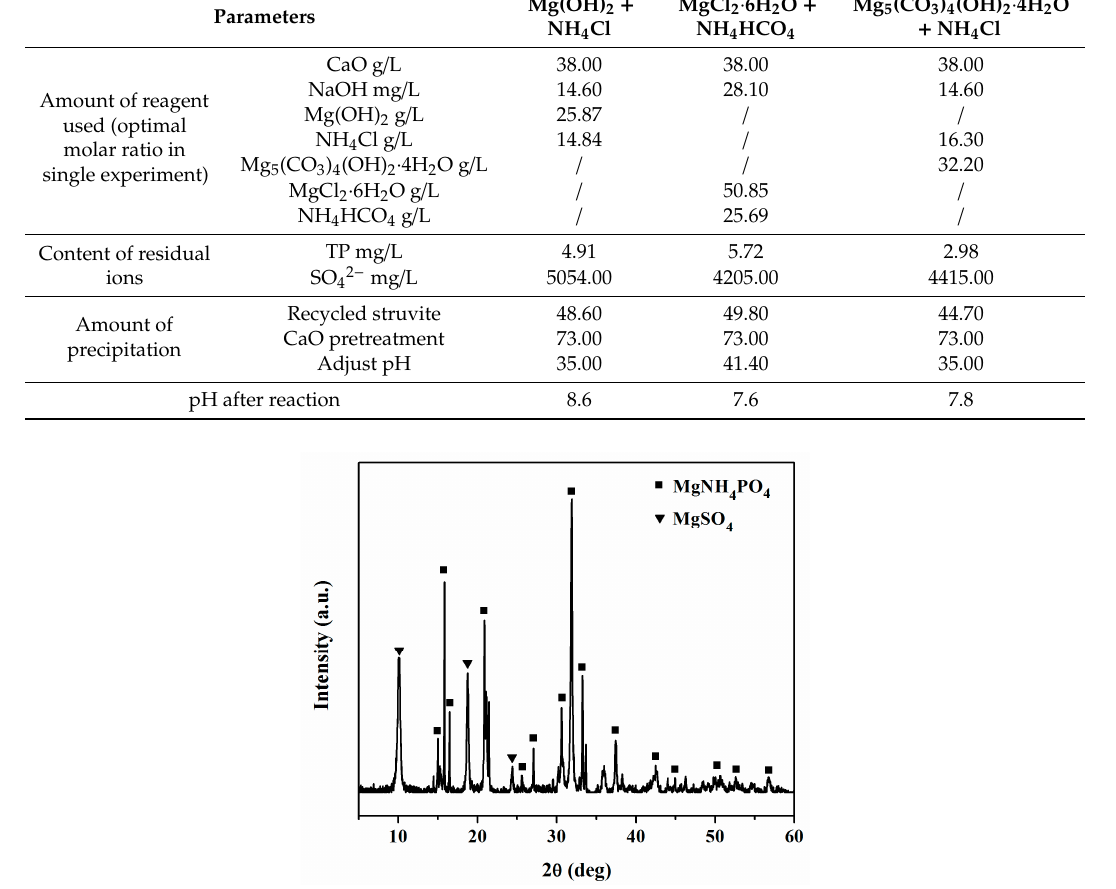
Figure 3. XRD patterns of struvite precipitation obtained by the reaction of Mg 5 (CO 3 ) 4 (OH) 2 · 4H 2 O and NH 4 Cl.